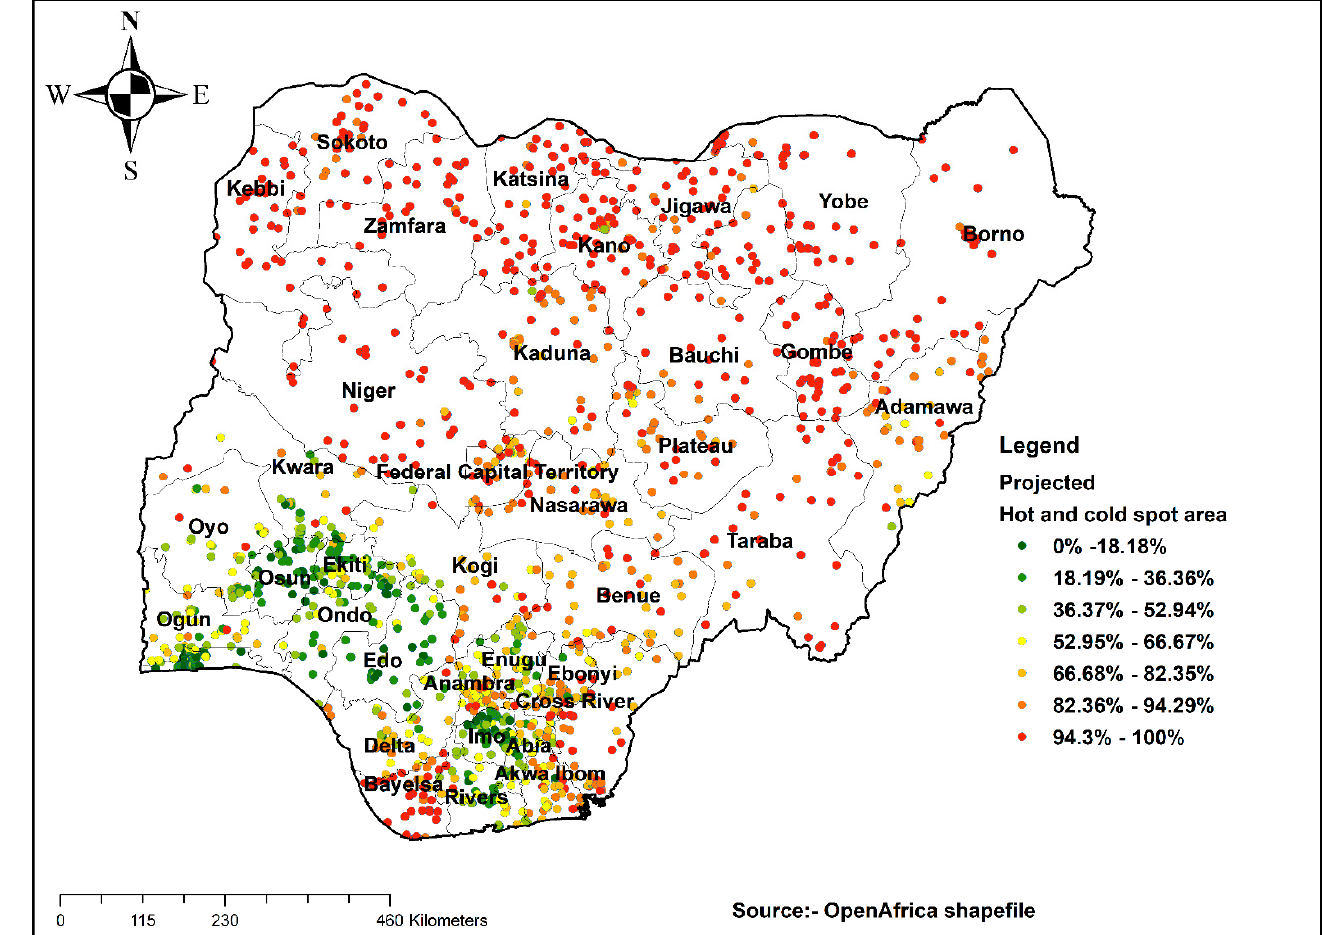
Figure 2. Hot spot analysis result of incomplete ANC visits in Nigeria, 2018.